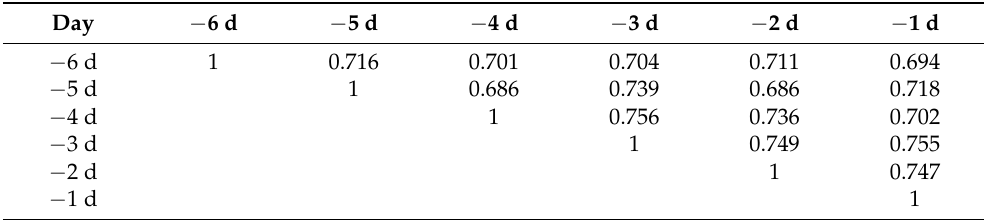
Table 2. The Euclidean Distance (ED) score for the diurnal pattern of hens using the feeder for each day from − 6 d to − 1 d.